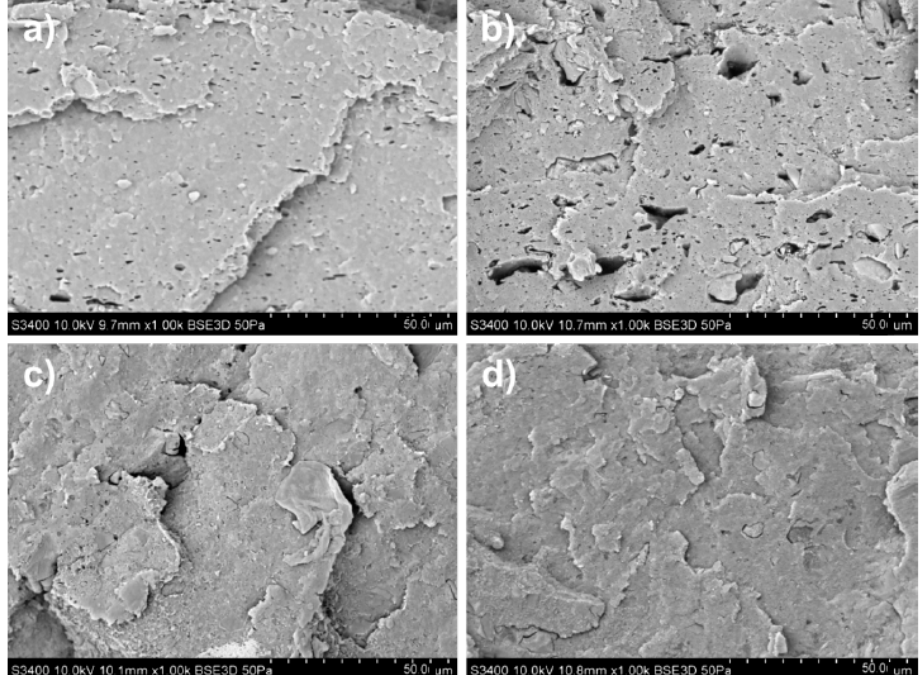
Figure 4. SEM images of fractured surface morphology for ( a ) GD03-FG-PLA-1, ( b ) GD03-FGPLA-5, ( c ) GD03-FG-PLA-10, ( d ) GD03-FG-PLA-15. Magnification 1000×; PLA-FG—PLA with plasticizer and compatibilizer, GD6—graphite/diamond mixture with 0.3 wt% ash content; numbers—wt.% of filler (GD03).